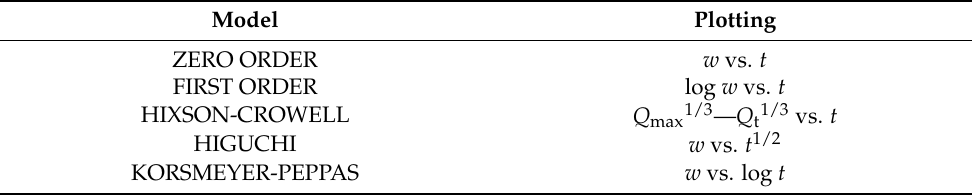
Figure 4. ( a ) The change in DEX concentration during drug release testing, ( b ) the cumulative mass of the released DEX, ( c ), the normalised mass of the released DEX, and ( d ) the first derivative of the released amount of DEX for coated samples. The error bars in ( a ) represent 95% confidence intervals. Table 2. Mathematical drug release models with corresponding plotting